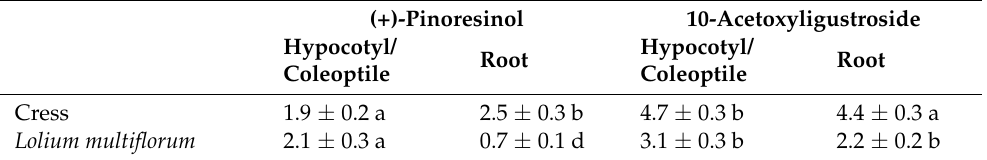
Figure 7. Effects of (+)-pinoresinol on the hypocotyl/coleoptile and root growth of cress and L. multiflorum. Means ± SE from three independent experiments with 10 seedlings for each determination are shown. Different letters on the symbols in the same panels indicate significant differences (Tukey’s HSD test, p ≤ 0.05). Table 3. IC 50 values (mM) of (+)-pinoresinol and 10-acetoxyligustroside of the growth of the hypocotyls/coleoptiles and roots of the cress and L. multiflorum. IC 50 values were determined with GraphPad Prism. Different letters in the same column indicate significant differences (Tukey’s HSD test, p ≤ 0.05).